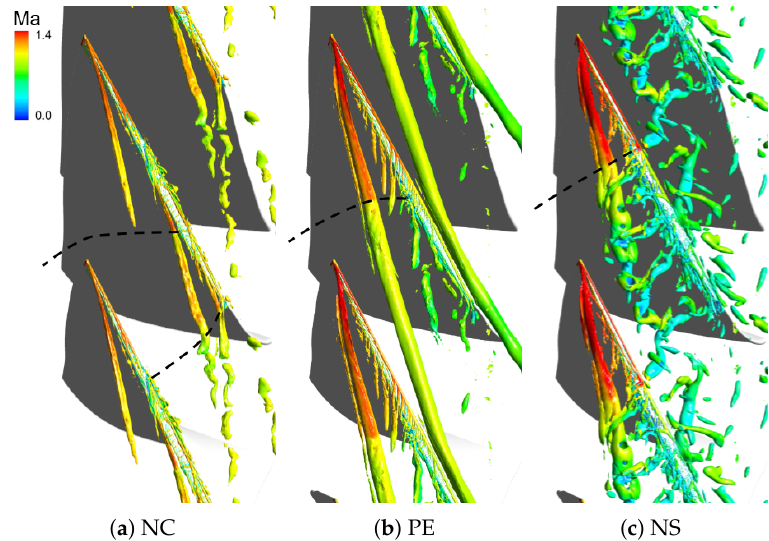
Figure 16. λ 2 Isosurface at tip region of R1 (colored by relative Mach number).